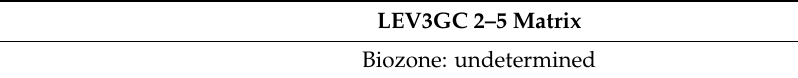
Table A13. Heraklion